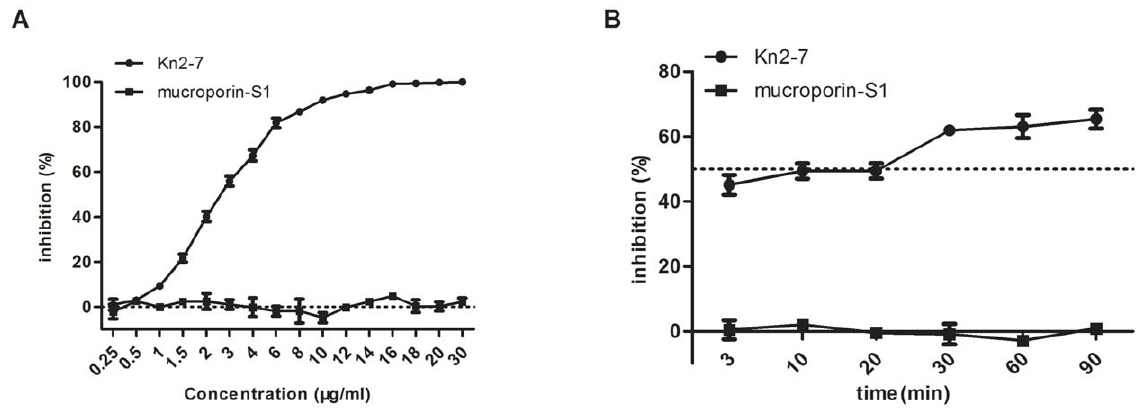
Figure 2. Dose- and time-dependent effects of Kn2-7 peptide against HIV-1 PV. (A) For dose-dependent effect experiments, serial dilution from 0.25 m g/ml to 30 m g/ml of Kn2-7 and mucroporin-S1 were incubated with 200 TCID 50 HIV-1 PV for 1 h at 37 u C and then added to TZM-bl cells, respectively. (B) For time-dependent effect experiments, 3 m g/ml of Kn2-7 and mucroporin-S1 were incubated with 200 TCID 50 of HIV-1 PV for 3 min, 10 min, 30 min, 60 min and 90 min, respectively. The viruses treated without any peptide were used as the control. Data are presented as mean 6 SD of three replicate samples for one representative experiment.